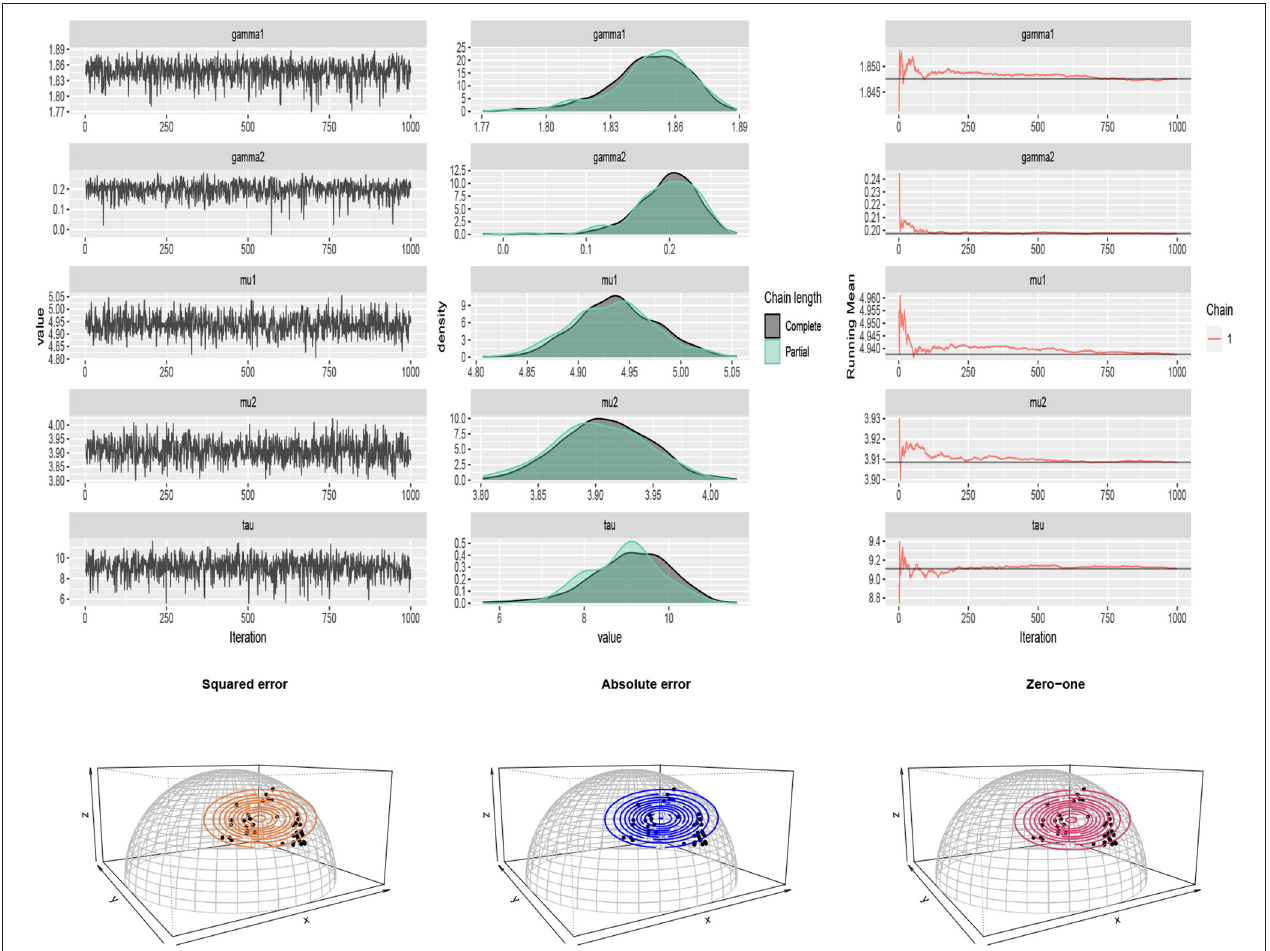
FIGURE 11 | (Top) traceplots, mean running and estimated posterior pdf plots of generated samples for ( µ 1 , µ 2 , τ , γ 1 , γ 2 ) in Table 5 for the household expenditures dataset. (Bottom) the scatter plot of the household expenditures dataset and the contour plot of the fitted distribution under different loss functions.